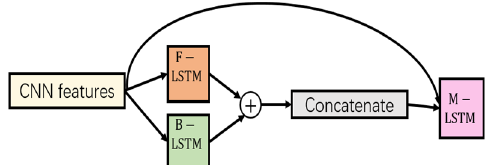
Figure 9. The approach to using the residual connection to combine the CNN features and the BiLSTM representations. ⊕ denotes the attention mechanism effects on the BiLSTM model.